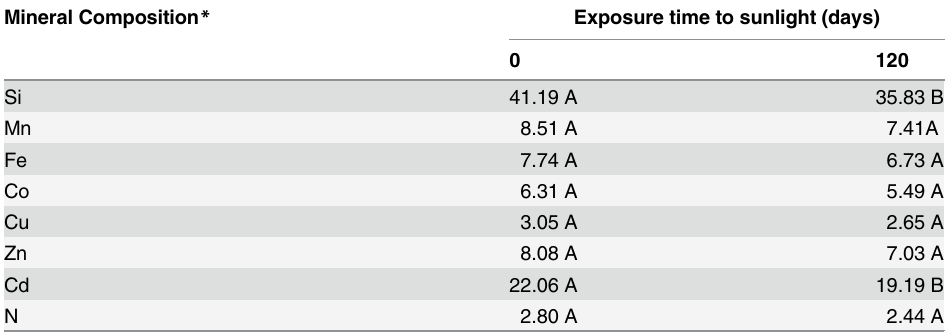
* Relative concentration of elements ((weight %) at the surface of the plastic bags, analyzed by scanning electron microscopy coupled to X ray diffraction (semi-quantitative method). Means followed by different letters within the same line differ at Tukey test (P <